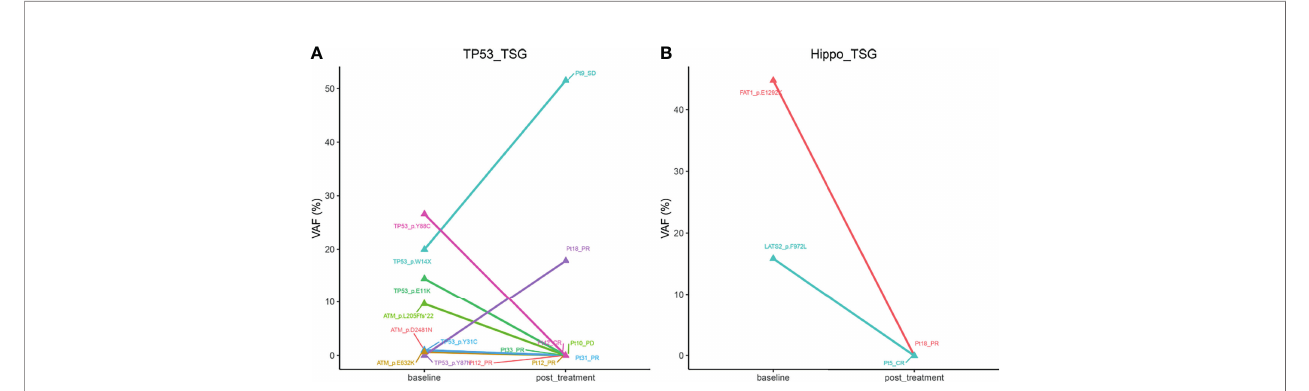
FIGURE 6 | The alterations of mean VAFs of mutated genes in Tp53 (A) and hippo pathways (B) in paired baseline and post-treatment samples from 18 B-cell lymphoma patients. VAF, variant allele frequency.